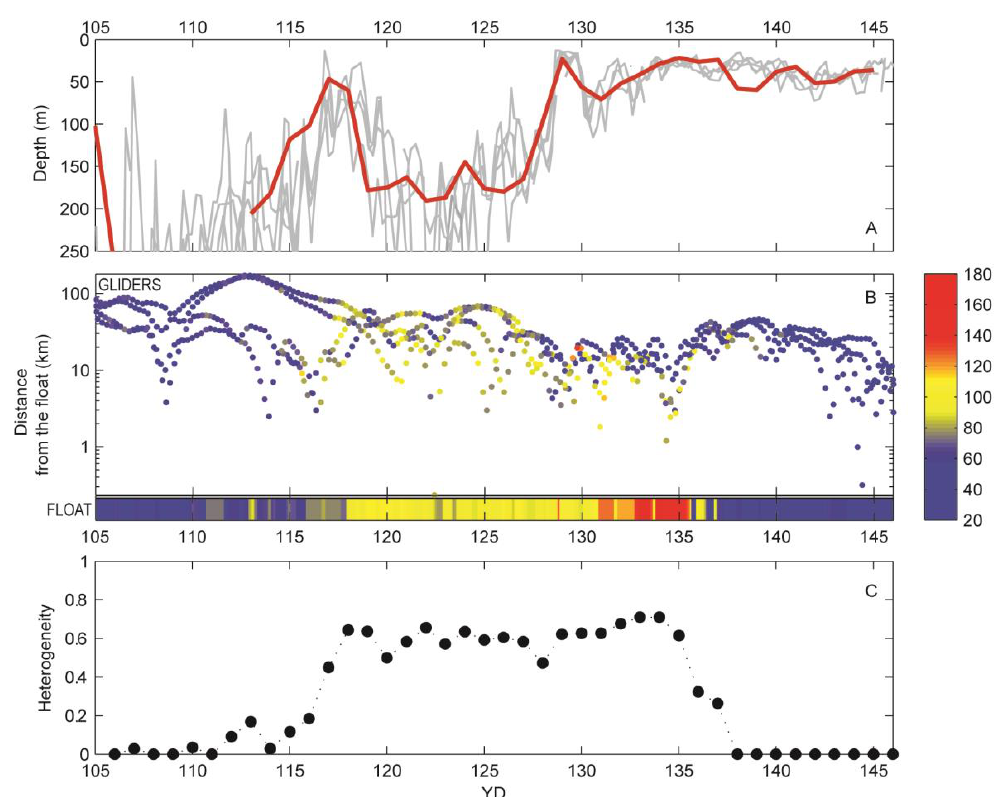
Figure 9. Spatial heterogeneity in phytoplankton community composition, determined from four gliders and the float. (a) Mixed-layer depths, from gliders (gray line) and float (red line). (b) Distances between gliders and Lagrangian float. Data are color-coded as Chl F/b bp ; dots represent glider data and color bar at bottom represents float data. (c) Heterogeneity index for community composition, defined in Sect. 2.4.